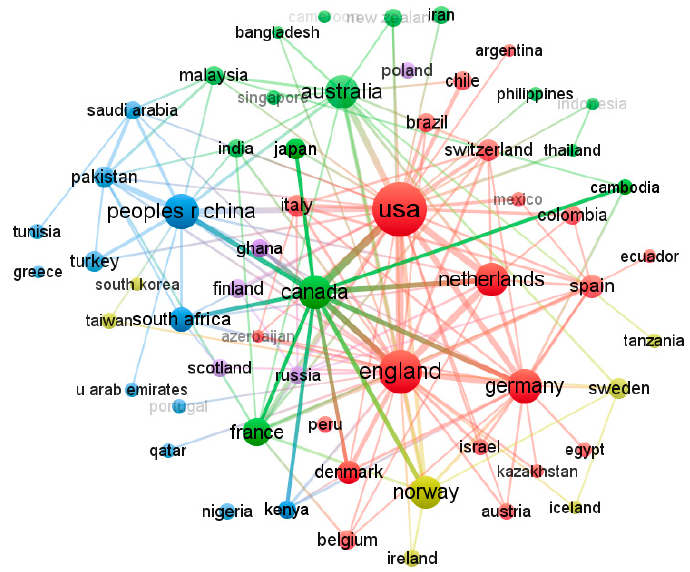
Figure 3. Network of country co ‐ authorship.